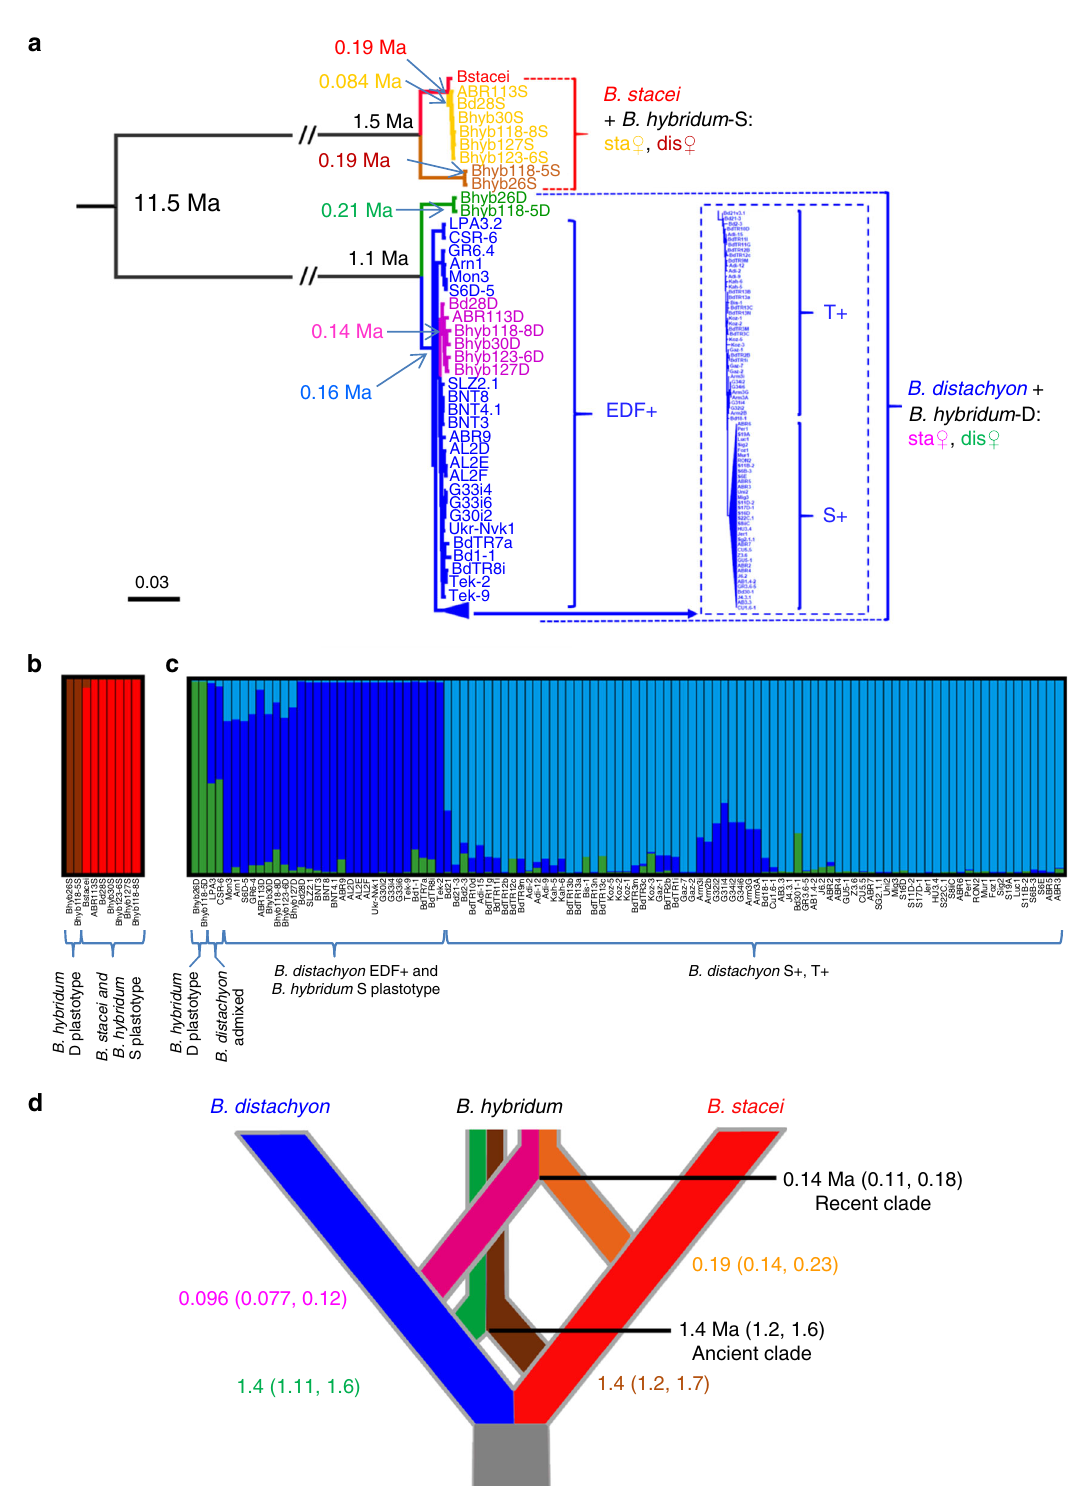
Fig. 4 Phylogenomic analysis of nuclear genomes and dating. a Best maximum-likelihood Brachypodium phylogenomic tree based on 745,854 syntenically aligned nuclear SNVs. Most branches show strong support (Supplementary Fig. 6). Divergence times for key branches are indicated based on the tree in Supplementary Fig. 7. B. stacei (red), B. distachyon (blue), B. hybridum D plastotypes (S subgenome, brown; D subgenome, green), B. hybridum- S plastotype (S subgenome, yellow; D subgenome, purple). b , c Bayesian genomic structure analysis based on 5443 SNVs. Percentages of membership of genomes and subgenomes to the inferred genomic groups: b B. stacei and S subgenomes ( k = 2), c B. distachyon and D subgenomes ( k = 3). d Cross-bracing analysis to determine the dates of formation for the recent and ancient B. hybridum clades. The numbers on the diagonals represent the estimated divergence times of the D and S subgenomes from the diploid progenitor B. distachyon and B. stacei genomic